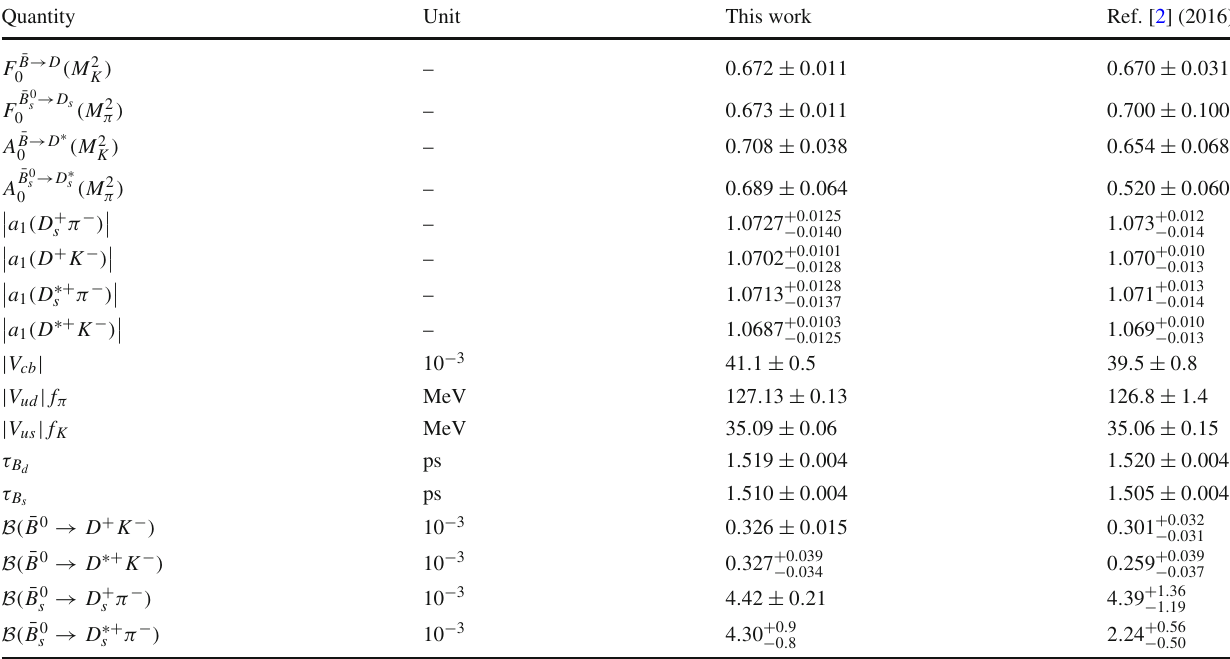
Table 1 Numerical inputs and results for the QCDF expressions for the branching fractions at leading power. We compare the results of Ref. [2] with our results. The predictions for the ¯ B 0 s branching frac-